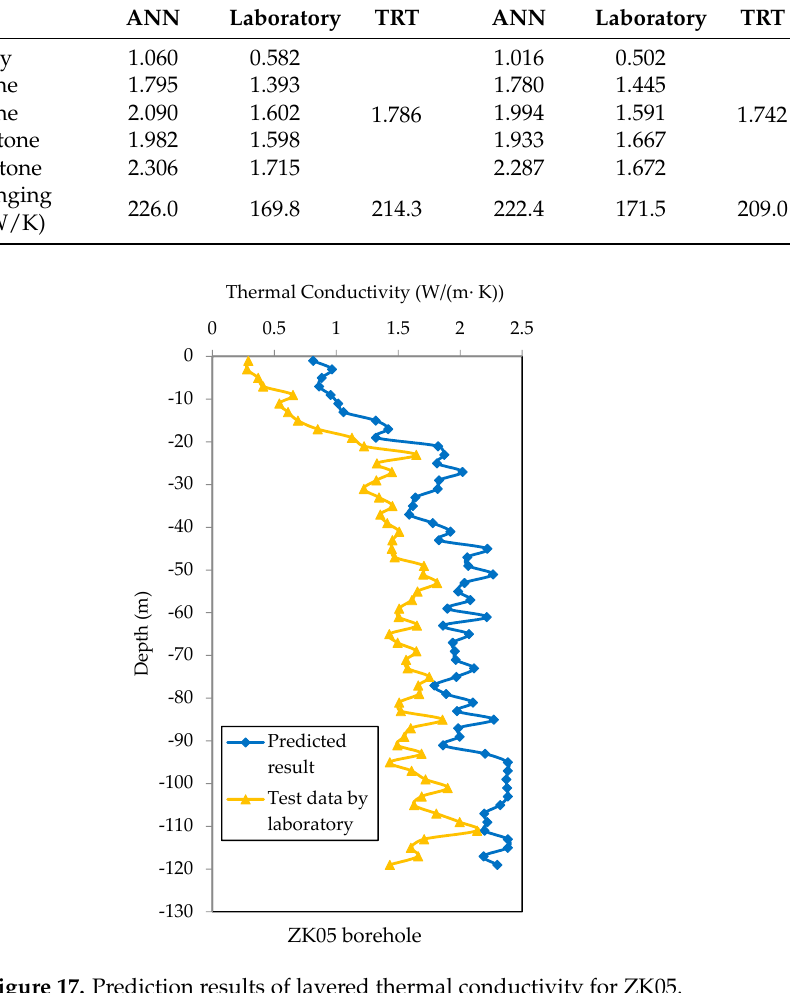
Table 4. Average layered thermal conductivity obtained by ANN models, laboratory test, and the standard TRT.